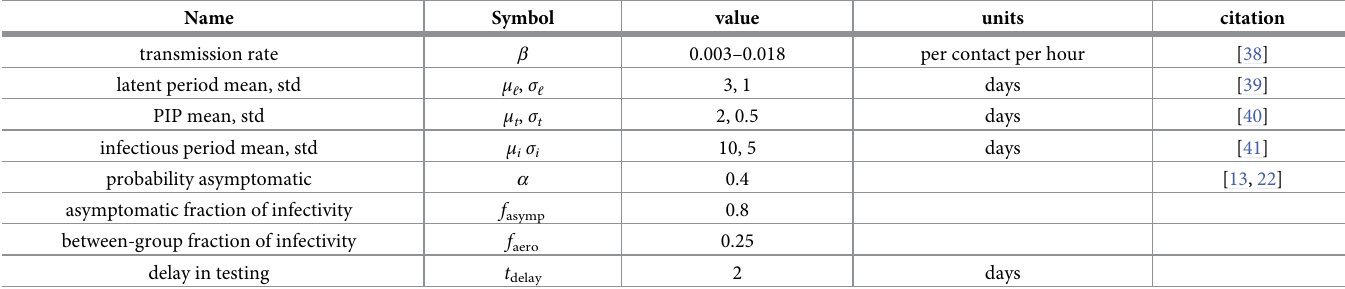
Table 1. Model parameters.